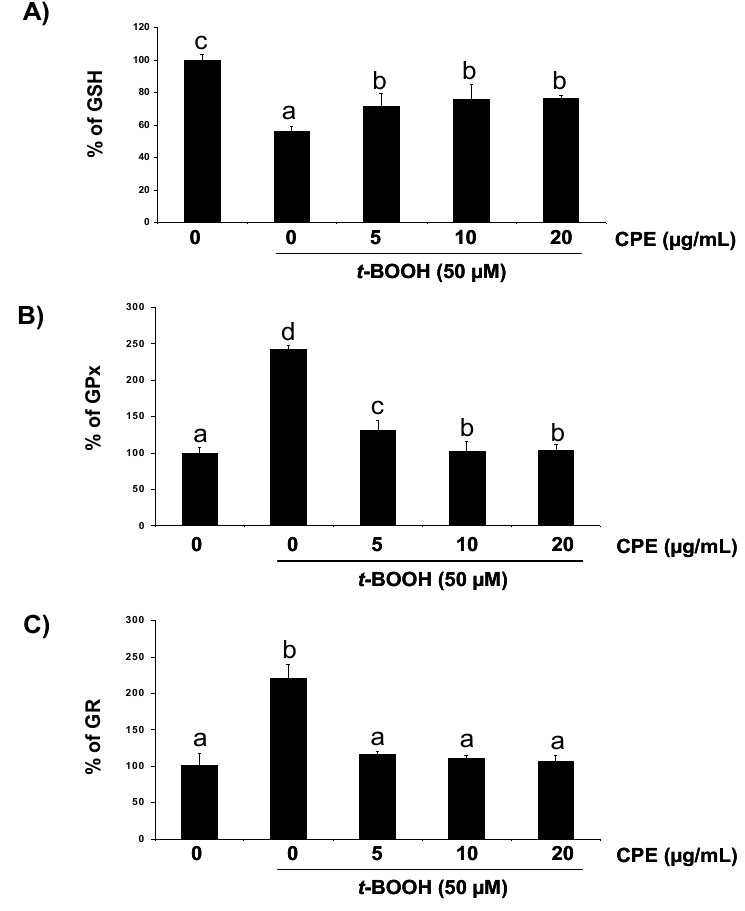
Figure 3. Protective effect of CPE on GSH concentration and GPx and GR activity. Ins-1E cells were treated with 5–20 μg/mL CPE for 20 h and then washed and submitted to 50 μM t -BOOH for 2 h prior to assay for GSH ( A ), GPx ( B ) and GR ( C ) to test for the protective effect. Values are means ± SD, n = 5. Values are expressed as a percent relative to the control condition. Different letters indicate statistically significant differences ( p < 0.05) among different groups.